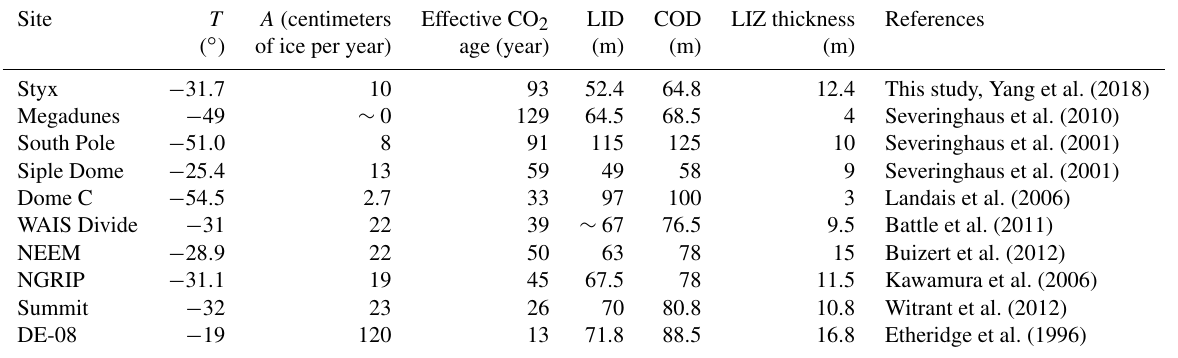
Table 1. Glaciological characteristics of Styx Glacier and other firn air sampling sites. Site T A (centimeters Effective CO 2 LID COD LIZ thickness of ice per